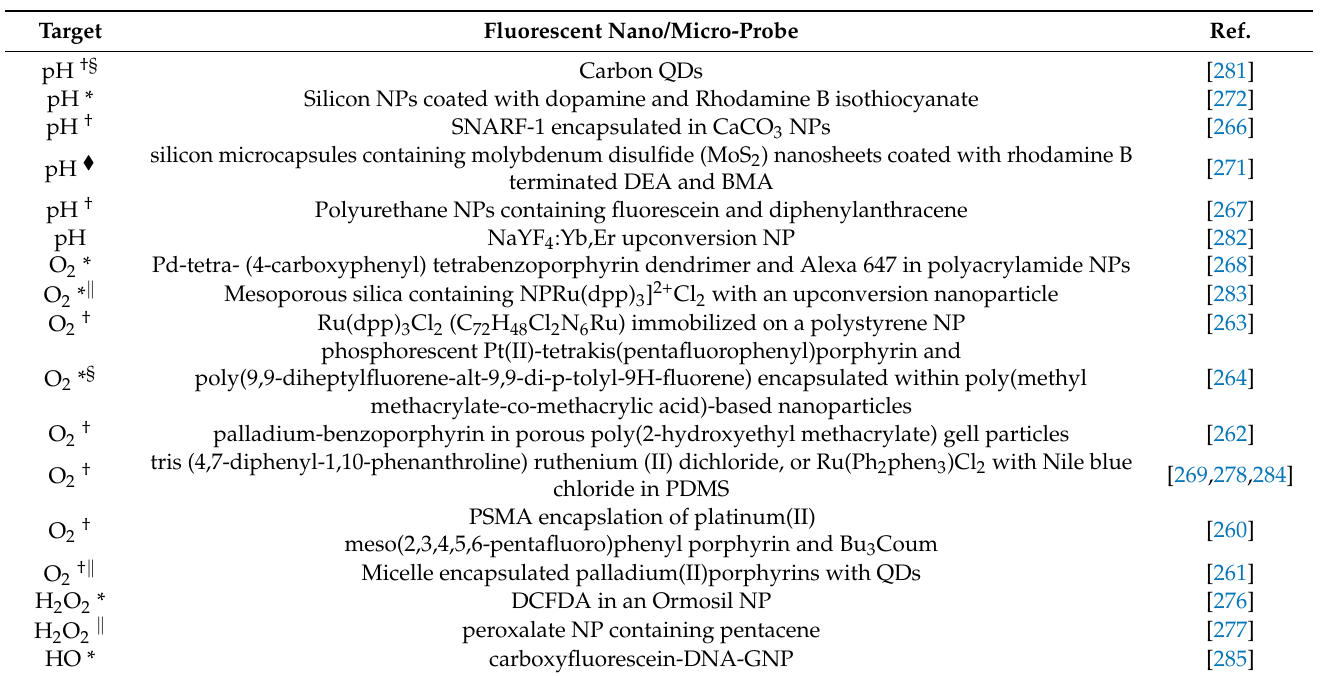
Table 1. Recently developed fluorescent nano-/microprobes for sensing O 2 , ROS, and pH that are applied intracellularly (*), extracellularly in 2D monolayer cell cultures ( (cid:7) ), 3D mapping (†), in vivo ( (cid:107) ) and long-term (>7 DIV) (§). Fluorescent Nano/Micro-Probe